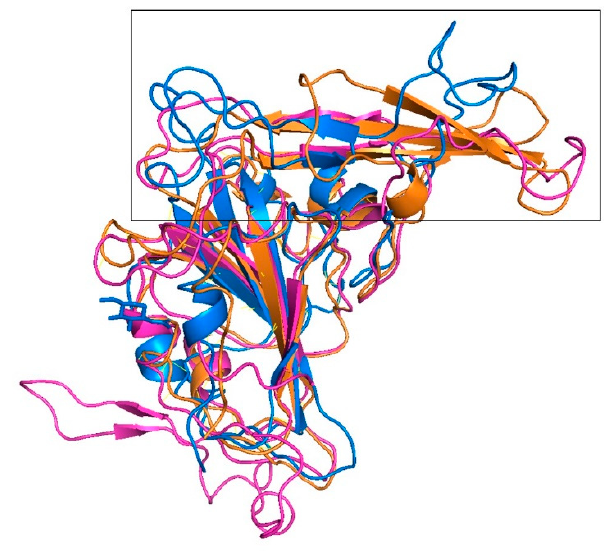
Figure 7. Superimposition of the structures of the RBDs of MERS-CoV and SARS-CoV-2. In comparison to the crystal structure of MERS-CoV (orange), the β -sheets in the crystal structure of SARS-CoV-2 (blue) are significantly shorter with a loop region orientated above the long β -sheets of MERS-CoV. The remodelled structure of SARS-CoV-2 (magenta) has longer β -sheets, and its loop region is more closely aligned with the β -sheets of MERS-CoV.